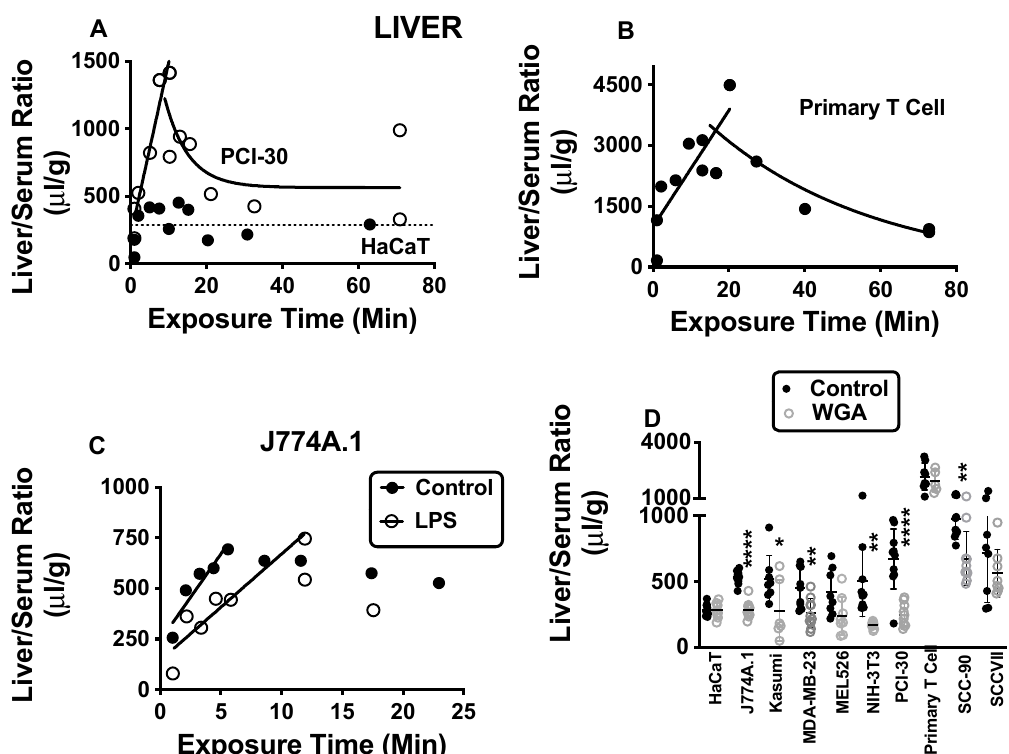
Figure 1. Liver sequestration of exosomes. In ( A ), the pattern as exemplified by PCI-30 for those exosomes that were sequestered by liver in a time-dependent manner (open circles, solid line, n = 13). That panel also illustrates HaCaT as an example of exosomes whose sequestration levels did not vary with time (solid circles, dashed line, n = 11). In ( B ), the most robustly sequestered exosome was derived from primary human T-cells (n = 13). In ( C ), the typical sequestration pattern as exemplified by J774A.1 for exosomes whose liver sequestration was inhibited by LPS treatment (n = 9 for control and for LPS). In ( D ), six exosomes (J774.1: n = 10 for control, n = 10 for WGA; NIH-3T3: n = 9 for control, n = 9 for WGA; Kasumi: n = 8 for control and 6 for WGA; MDA-MB-23: n = 9 for control, n = 10 for WGA; PCI-30: n = 10 for control; n = 10 for WGA; SCC-90: n = 10 for control; n = 10 for WGA) had sequestration that was increased by WGA. See Figure S2 for exosomes not shown here. Regression analysis was used for panels ( A – C ) and t-tests for panel ( D ). * p < 0.05; ** p < 0.01; **** p << 0.001.